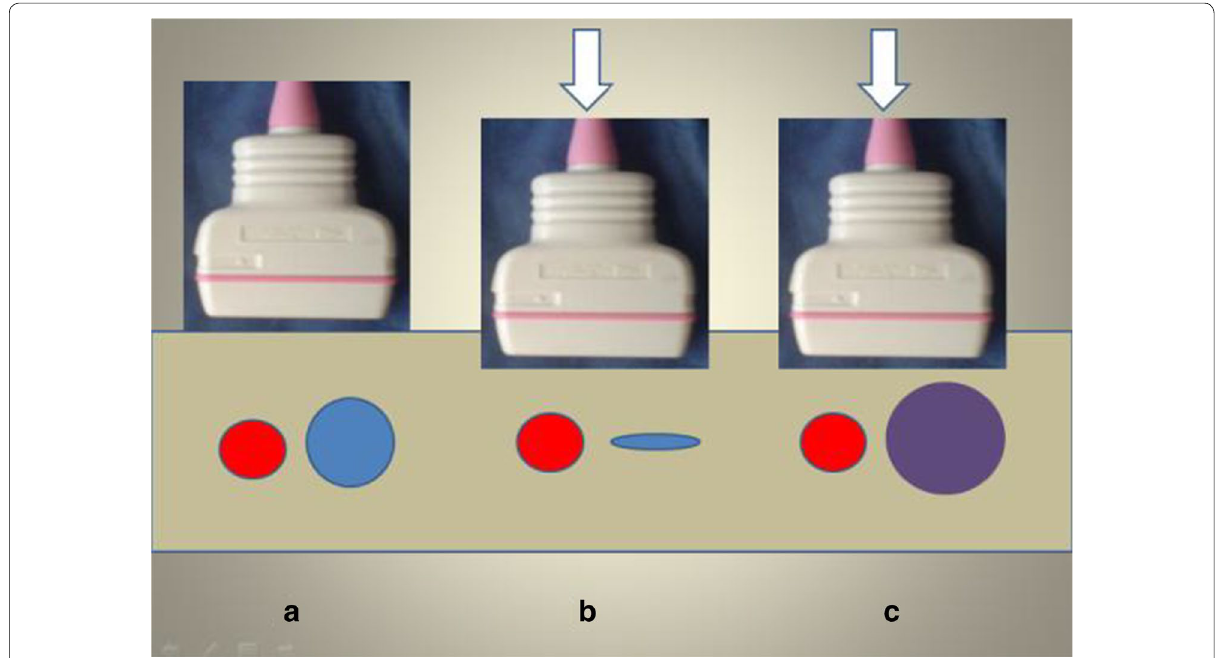
Fig. 6 Schematic representation of the compression vein technique. a Without compression, b compressive normal vein, c non compressive venous thrombosis